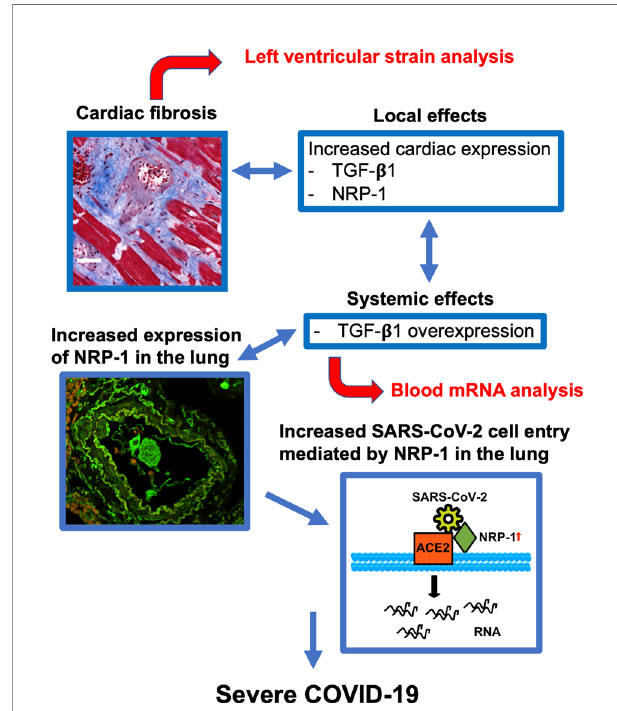
FIGURE 5 | Predictive model for severe COVID-19. Cardiac fi brosis may predispose COVID-19 patients to severe disease courses due to increased cardiac expression and systemic overexpression of TGF- b 1. Elevated expression of NRP-1 in fi brotic tissue can facilitate cell entry of SARS-CoV-2 via ACE2 and thereby promote viral infectivity, leading to severe disease courses of COVID-19. Risk strati fi cation can be performed in newly hospitalized patients using echocardiographic strain imaging and qPCR analysis of whole blood TGF- b 1